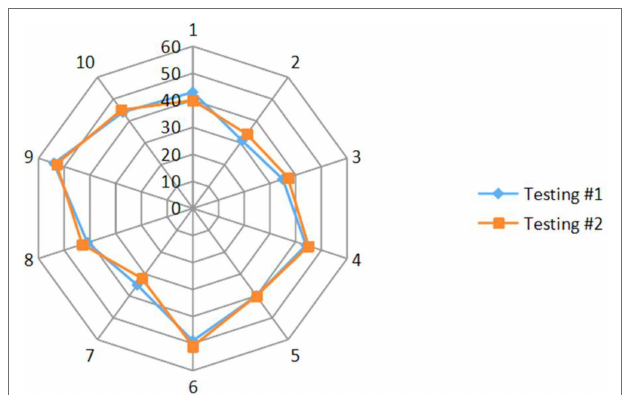
FIGURE 3 | Radar plot of the MUNE distribution of the 10 subjects for both visits. The numbers around the outside of the plot represent the individual subject number (1–10), and the numbers (0–60) are on contours of equal MUNE.